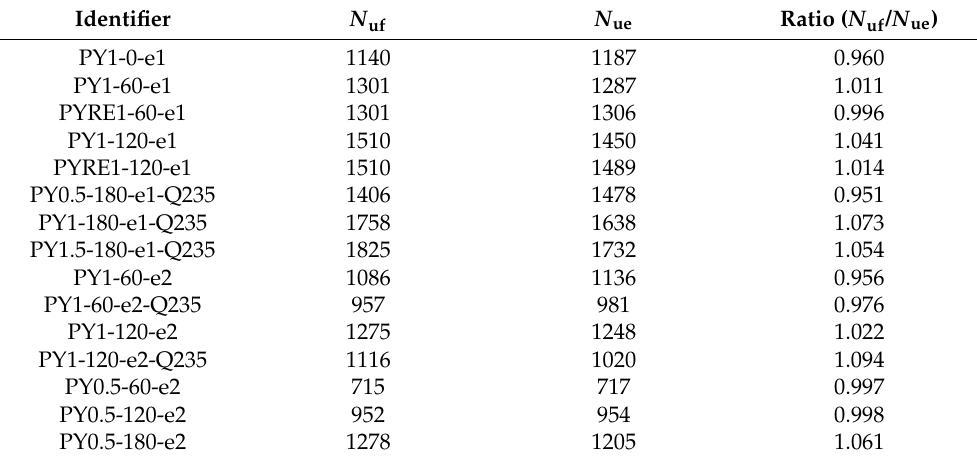
Table 3. Comparison of FEM and experiment peak